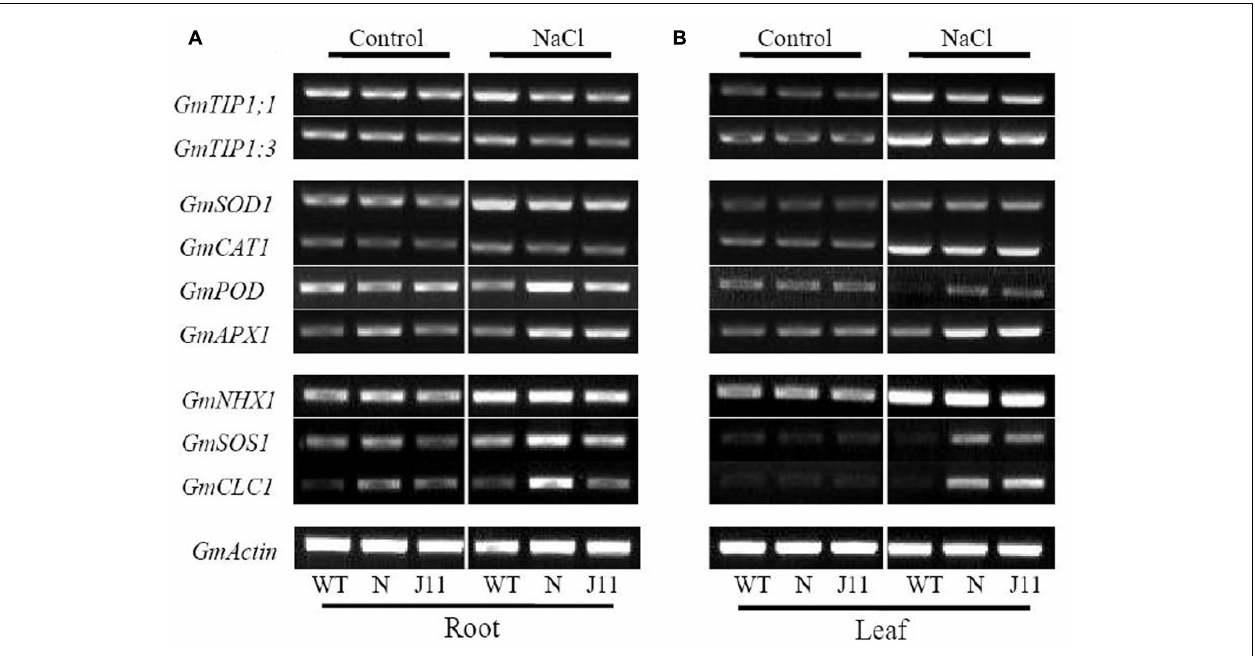
FIGURE 8 | Transcriptional patterns of stress-related genes in plants of NaCl-treated WT and PgTIP -transgenic soybean lines. At the time of the 1st trifoliate leaf expansion, plants of PgTIP1- transgenic soybean lines N and J11, and WT were subjected to 150 mM NaCl treatment for 24 h, the genes expression patterns of GmSOD1 , GmCAT1 , GmPOD, GmAPX1 , GmNHX1 , GmSOS1, GmCLC1, GmTIP1;1, and GmTIP1:3 in (A) roots and (B) leaves were analyzed by semi-quantitative RT-PCR using a pair of gene-specific primers (listed in Table 1 ), which was performed at least three independent replicates, and the representative one was showed. The housekeeping gene GmActin was used as an internal